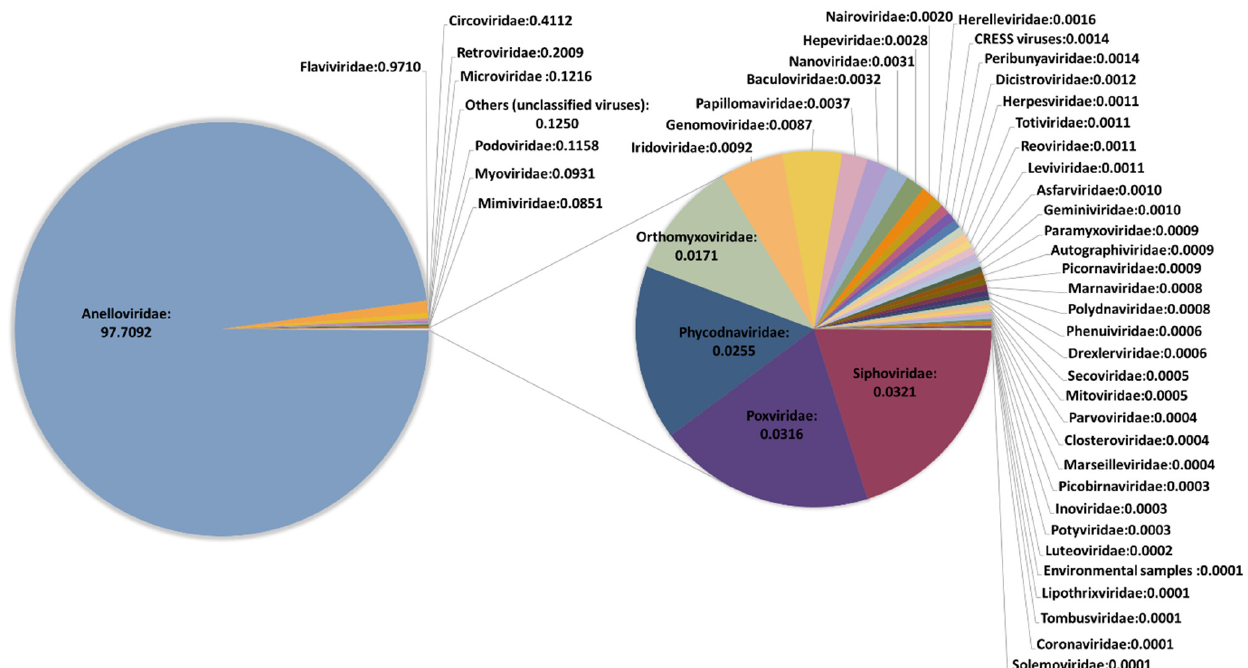
Figure 1. Description of the virome characterized in this study. The classification is shown at the family level. Frequencies were obtained excluding spiked viruses.